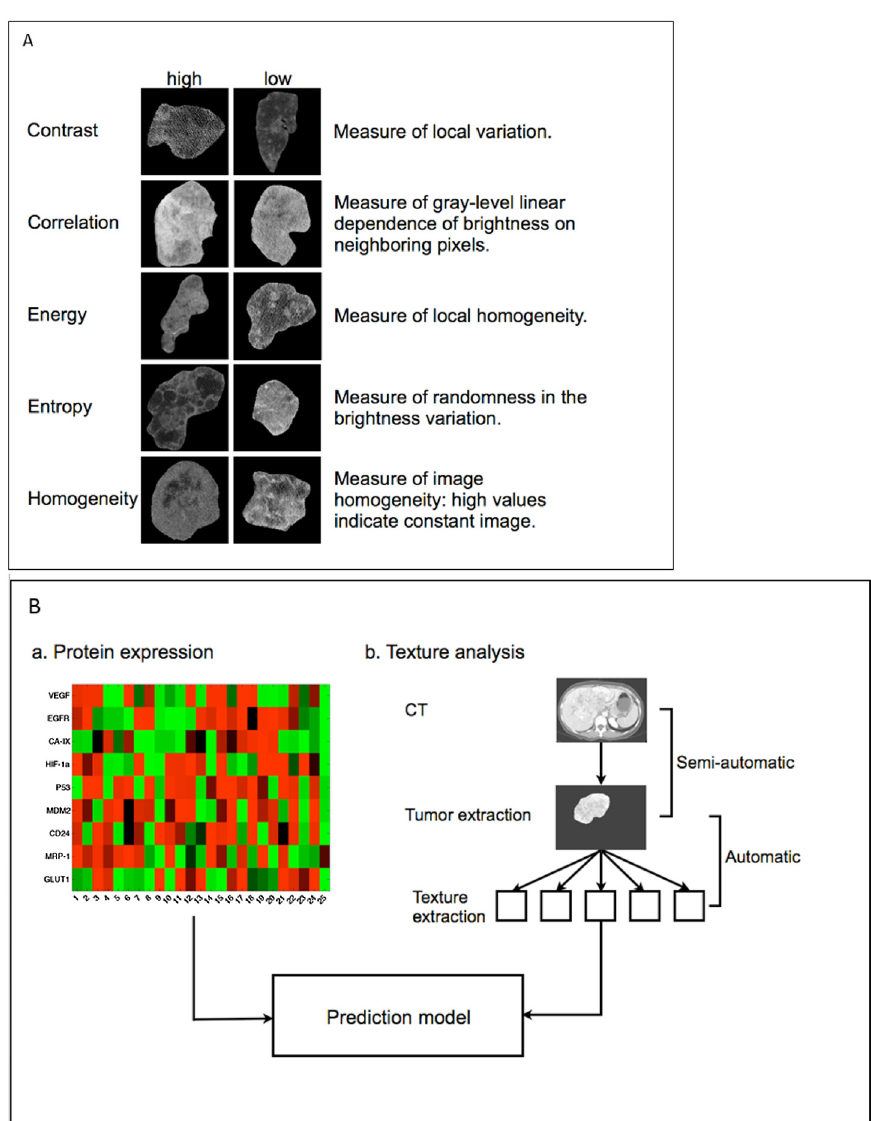
Fig 1. Representative tumors with high and low values for each texture feature (A). Schematic of prediction model of protein expression constructed from quantitative imaging phenotypes. Quantitative image phenotypes are derived via texture analysis: the tumor region is extracted from CT, texture feature statistics are automatically computed based on the region of interest (B).